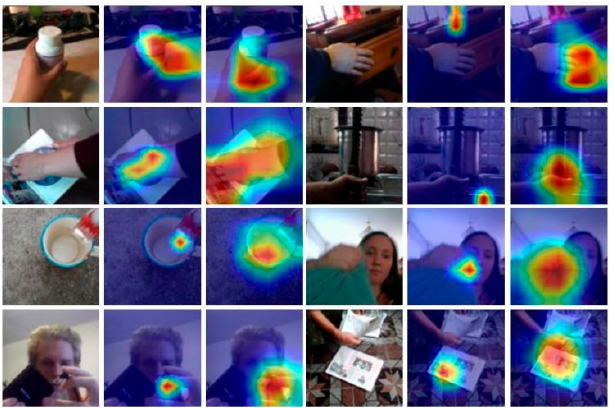
Figure 10. Visualization of activation maps. The first and the 4th columns refer to the original video; The second and the 5th column refer to the result of the baseline; The 3rd and the 6th column refer to our results.